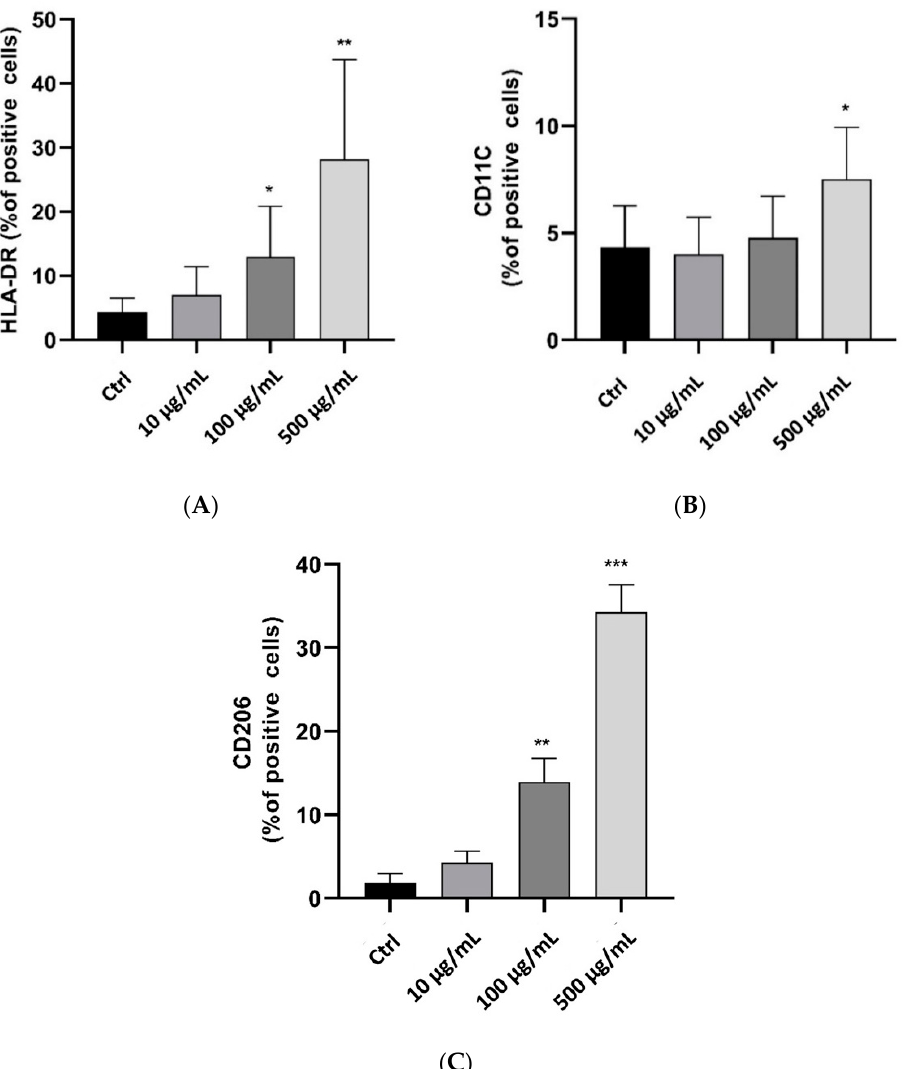
Figure 6. Treatment of Thp-1-like macrophage cells with myrrh extract and the effect on M1 or M2- like phenotypic cell surface markers. In vitro dose-dependent activation of M1 phenotype markers on HLA-DR ( A ) and CD11C ( B ) following treatment with myrrh extract. Dose-dependent induction of CD206 M2-like-phenotype marker following in vitro treatment with myrrh methanolic extract ( C ) (* p < 0.05, ** p < 0.01, *** p < 0.005).